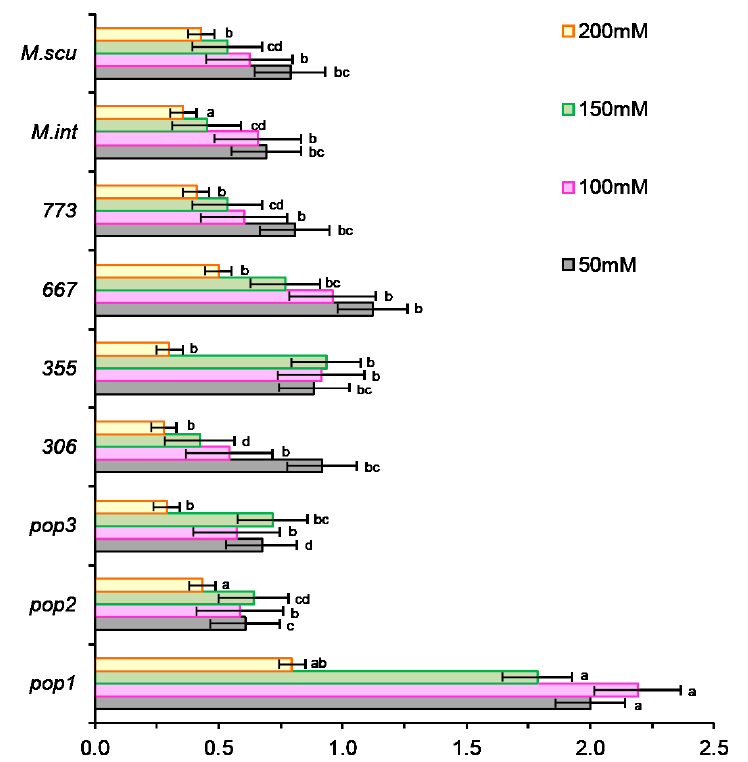
Figure 6. E ff ect of salt stress (0, 50, 100, 150, 200 mM NaCl) on tolerance index (TI). Tolerance index of Pop1, Pop2, Pop3, 306, 355, 667, and 773 , compared to one population of M. intertexta ( M. int ) and one population of M. scutellata ( M. scut ). The means are averages of 25 plants (5 plants / n = 5 repetitions for each salt treatment). The standard deviation annotated by di ff erent lower-case letters in the same stress type indicate significant di ff erences at p < 0.05, Tukey’s post hoc test.